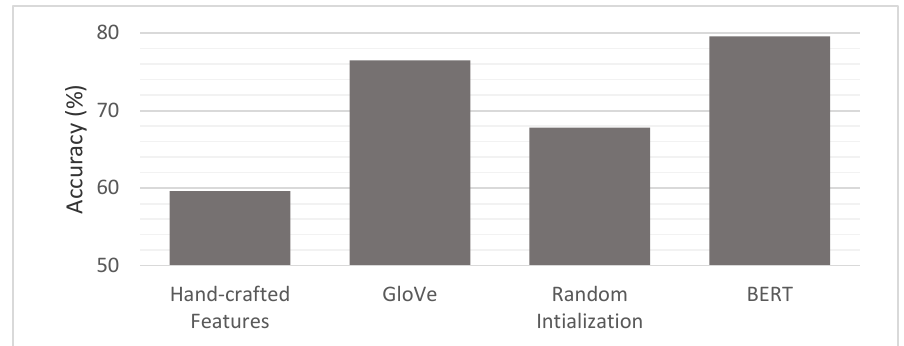
Figure 10. Accuracies from the four representation types.